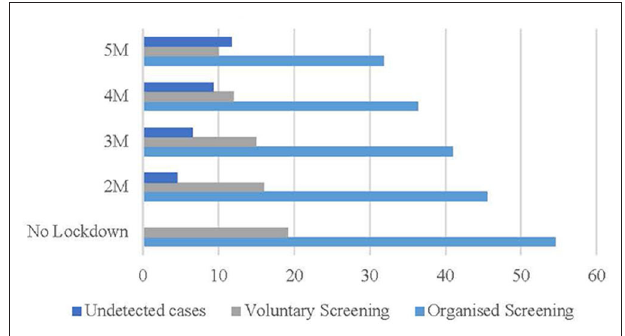
FIGURE 3 | Pessimistic scenario (%). Source: Osservatorio Screening (17) and authors’ elaboration.